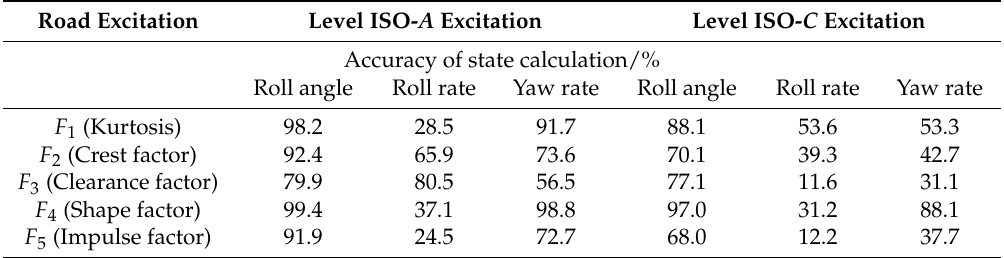
Table 7. Simulation accuracy of comparing 6-DOF model and CARSIM ® with steering wheel 5 ◦ input. Road Excitation